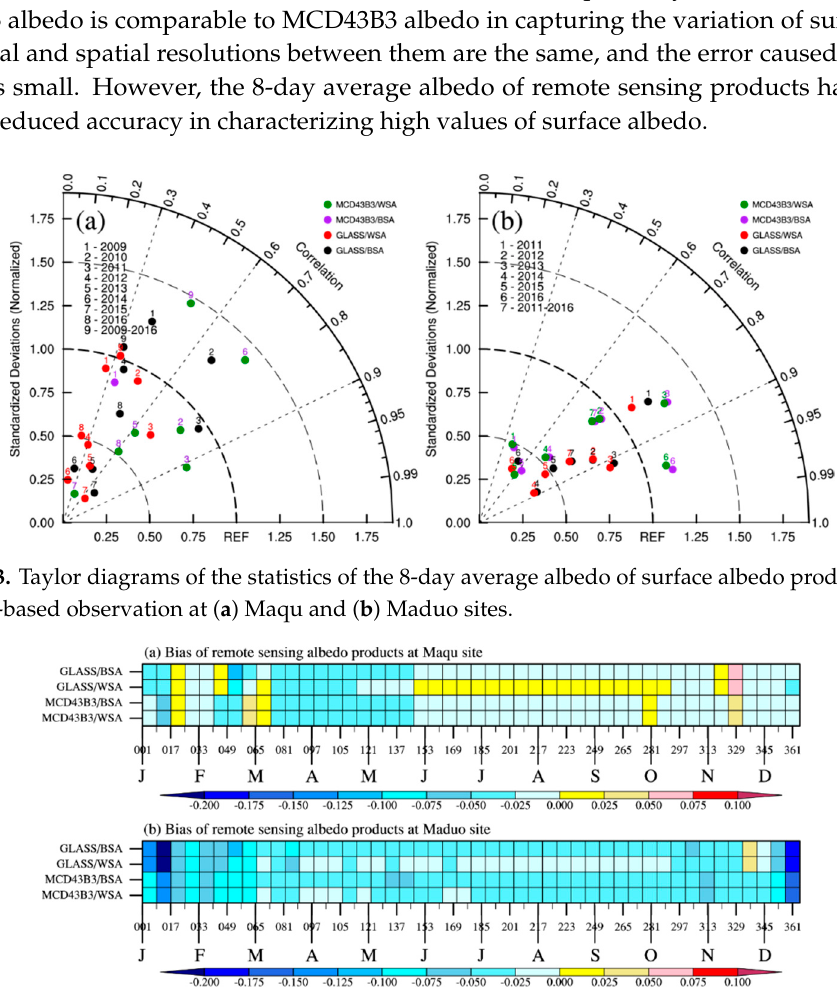
Figure 2. Comparison of the 8-day average albedo over the years between the GLASS, MCD43B3 albedo, and ground-based observation at ( a ) Maqu site from January 2009 to June 2017 and ( b ) Maduo site from January 2011 to June 2017. Table 3. Root mean square error (RMSE) and bias between GLASS, MCD43B3 albedo, and ground- based observation at (Figure 2a) Maqu site from January 2009 to June 2017 and (Figure 2b) Maduo site from January 2011 to June 2017.